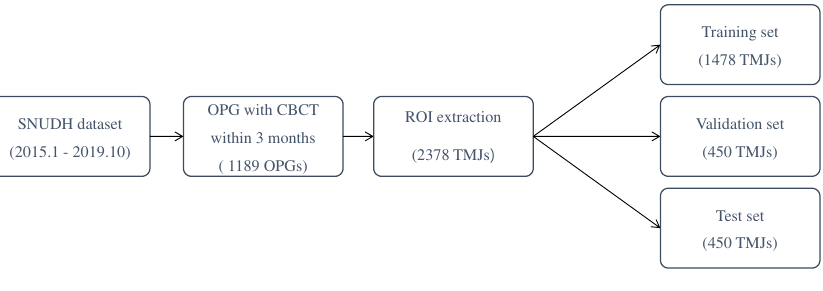
Figure 3. Clinical datasets used for training, validation, and